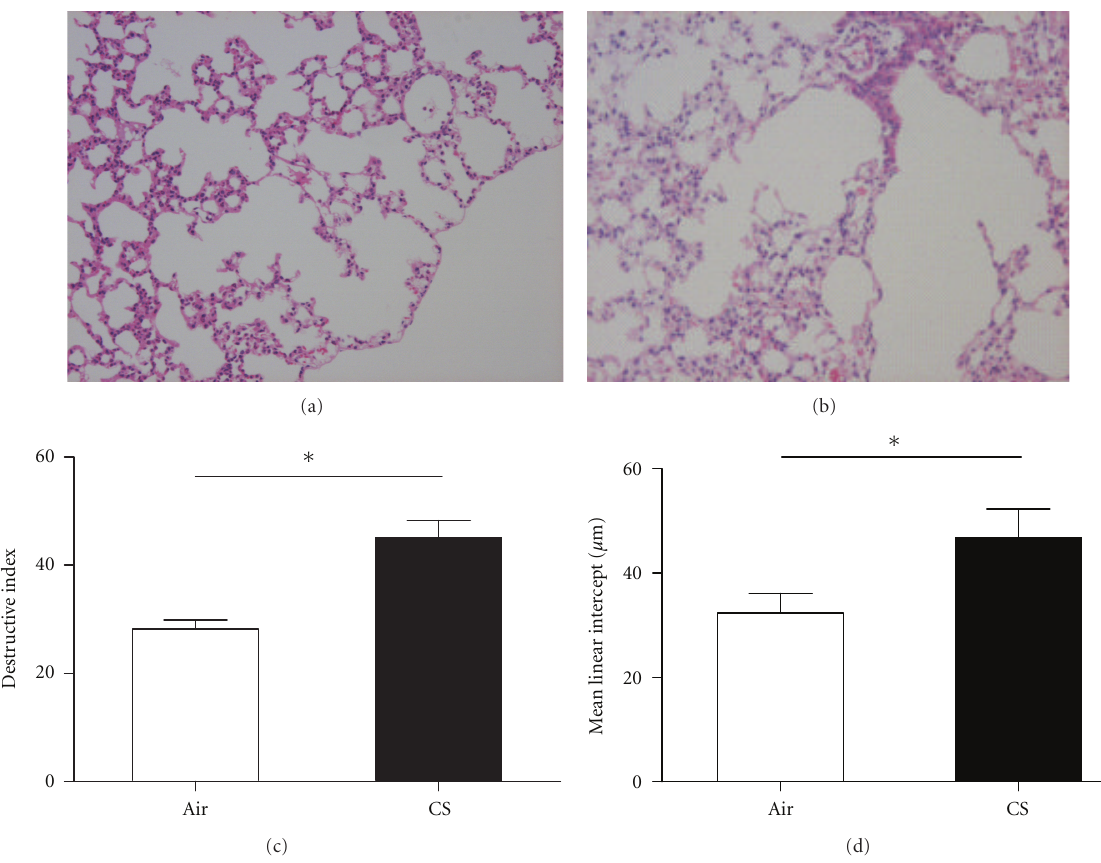
Figure 1: Photomicrographs of haematoxylin and eosin-stained lung tissue of air- and CS-exposed mice at 24 weeks (magnification, × 100). Smoke exposure clearly induced alveolar wall destruction and airspace enlargement in mice. (a) Air-exposed mice, (b) CS-exposed mice. Quantification of pulmonary emphysema. Morphometry of the lungs after chronic (24 weeks) air or CS exposure: (c) DI and (d) Lm values of mice. Results are expressed as means ± SD. n = 10 animals/group; ∗ P < 0 .